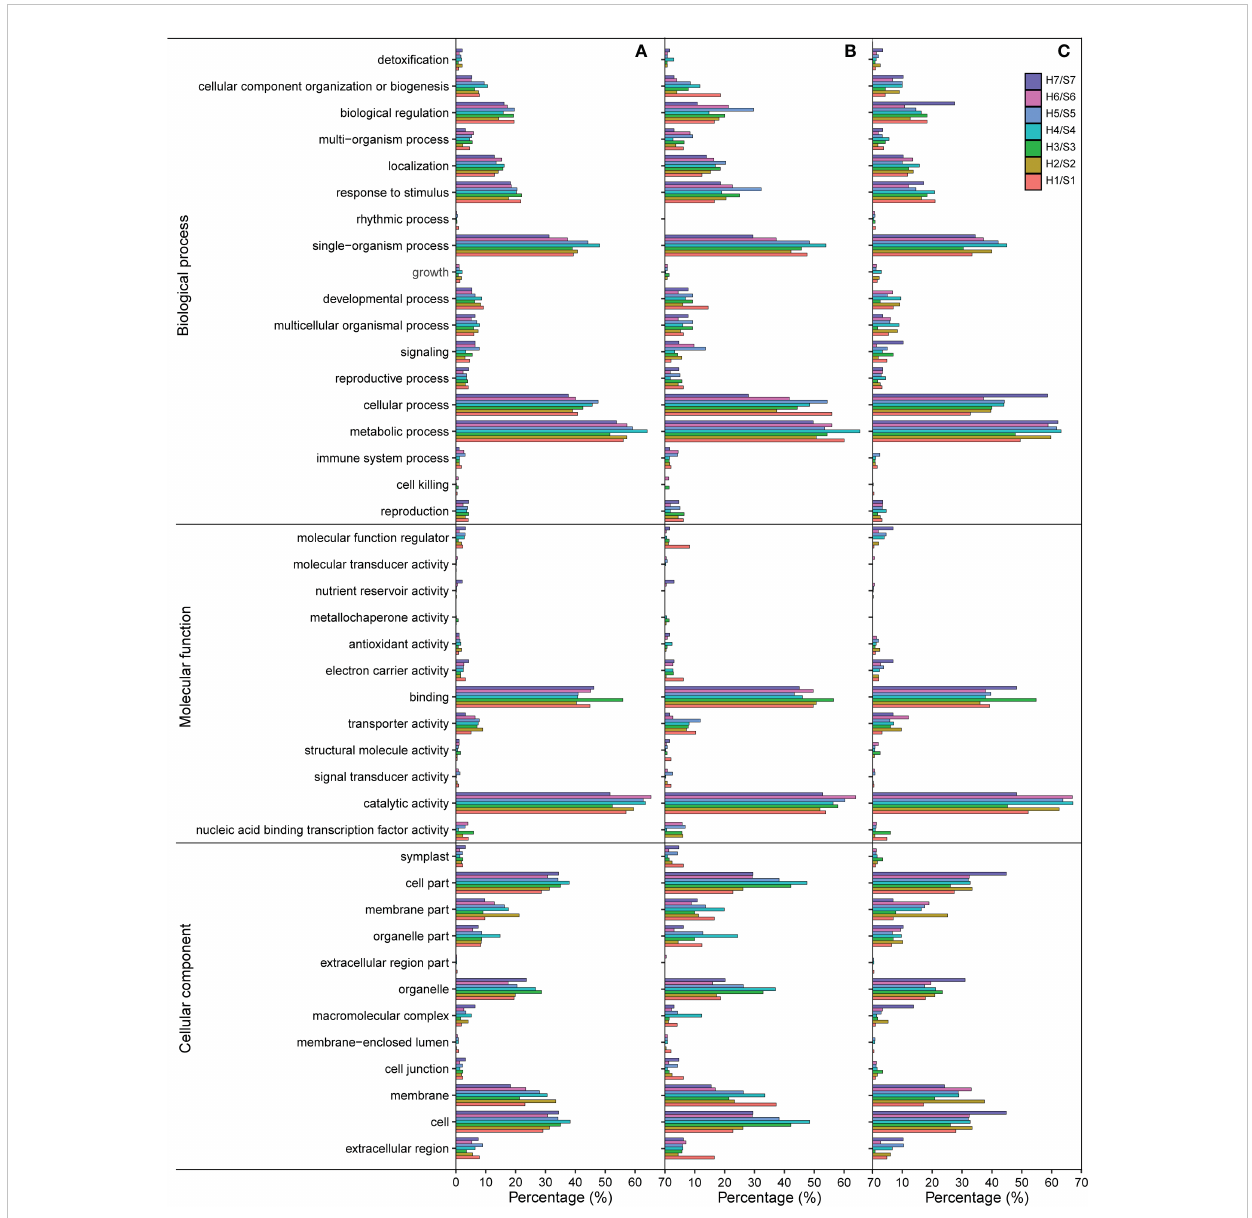
FIGURE 5 GO terms of DEGs in the different of sweet potato cultivars under the drought stress. (A) , GO terms of all DEGs; (B) , GO classi fi cations of up- regulated DEGs; (C) , GO terms of down-regulated DEGs. H1/S1, drought-treated Shangshu-9/control Shangshu-9; H2/S2, drought-treated Chaoshu-1/control Chaoshu-1; H3/S3, drought-treated Xushu-22/control Xushu-22; H4/S4, drought-treated Z15-1/control Z15-1; H5/S5, drought- treated Xushu-18/control Xushu-18; H6/S6, drought-treated Jishu-26/control Jishu-26; H7/S7, drought-treated Xuzi-8/control